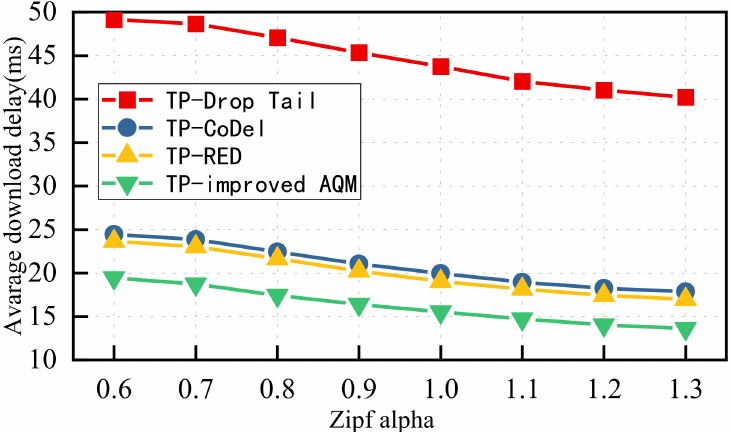
Figure 15. The average content download delay under different